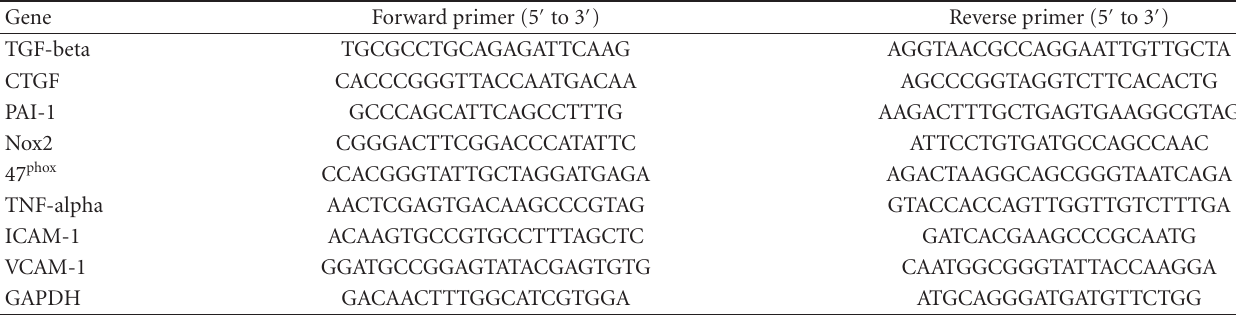
Table 1: Primers for real-time